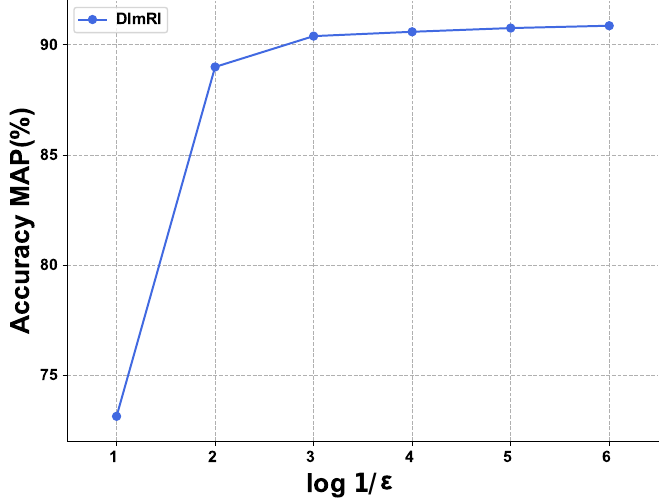
Figure 8. The figure shows the effect of (cid:101) on the MAP score using our DlmRl.